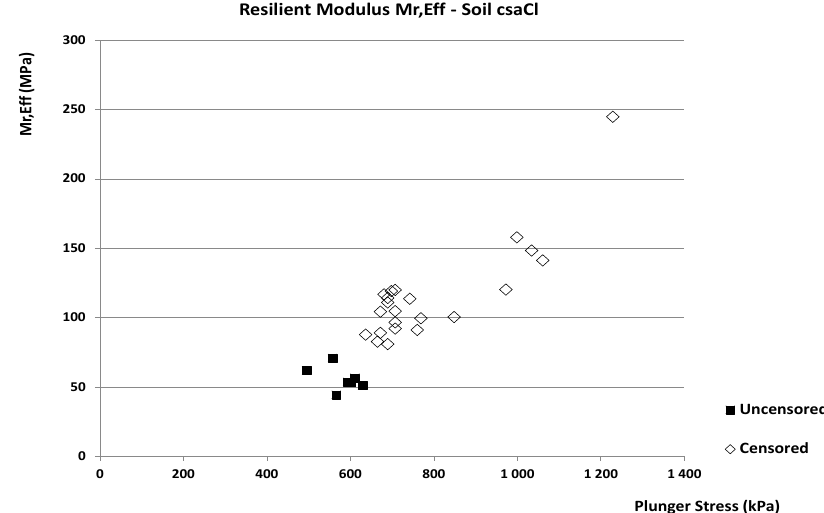
Figure 6. Resilient modulus M r,eff for soil csaCl.